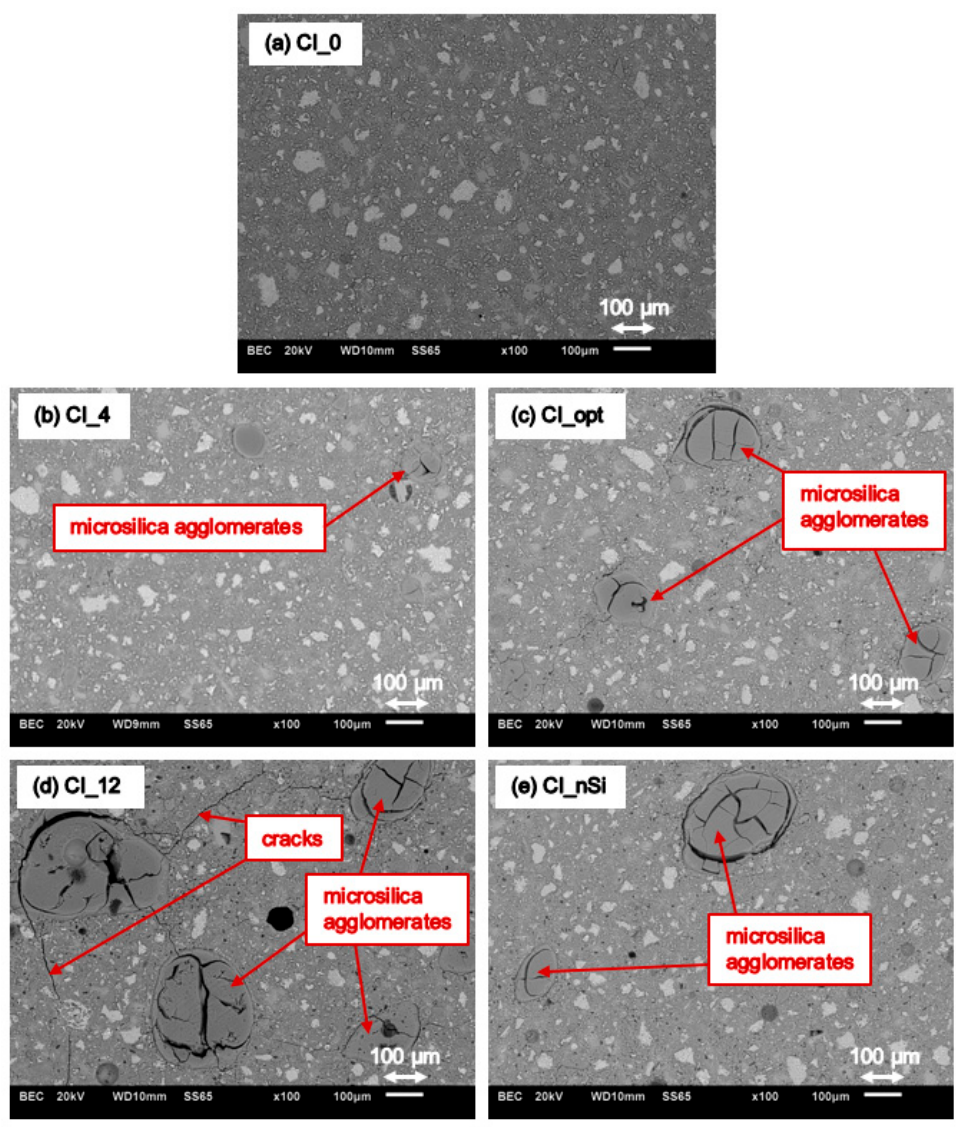
Figure 12. Microstructure of series: ( a ) CI_0, ( b ) CI_4, ( c ) CI_opt, ( d ) CI_12 and ( e ) CI_nSi. Considering the above results, it should be said that the reference series CI_0 is char- acterized by a homogeneous microstructure, free of inclusions, cracks, or discontinuities (Figure 12a). On the other hand, in the series with the addition of microsilica, agglomer- ates of microsilica with a size greater than 100 µm can be seen, e.g., in Figure 12c. In the case of the series having the highest percentage of microsilica, i.e., CI_12, it is also seen that, in addition to the large number of agglomerates, cracks in the structure are clearly visible, as shown in Figure 12d. It seems that the presence of oversized microsilica may be an effect of an insufficient and non-effective mixing process, and in consequence, may cause deterioration of hardened cement paste structure in regard to its mechanical prop- erties. The negative effect of agglomerated and oversized microsilica, acting as an aggre- gate rather than micro-size filler, was also observed in work [35].